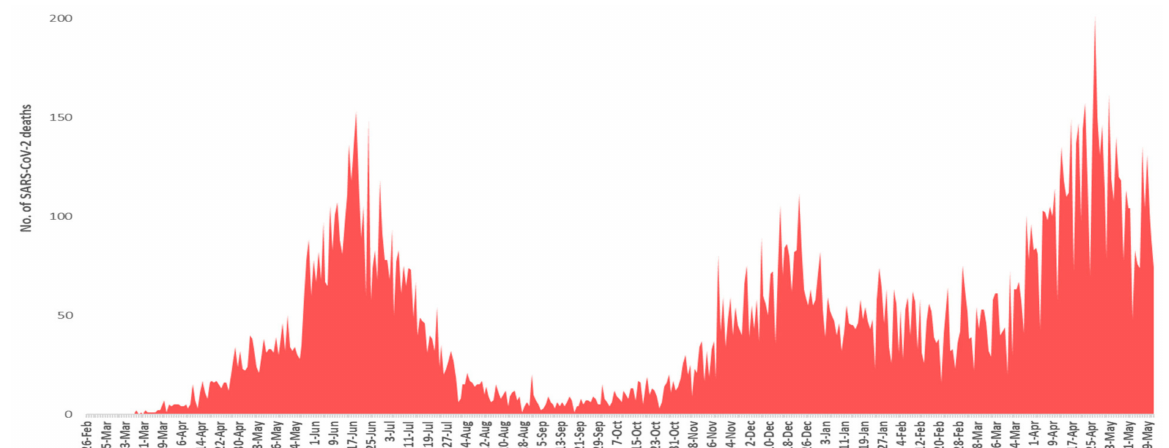
Figure 3. Month-wise details of deaths caused by SARS-CoV-2 starting from February 2020 to May